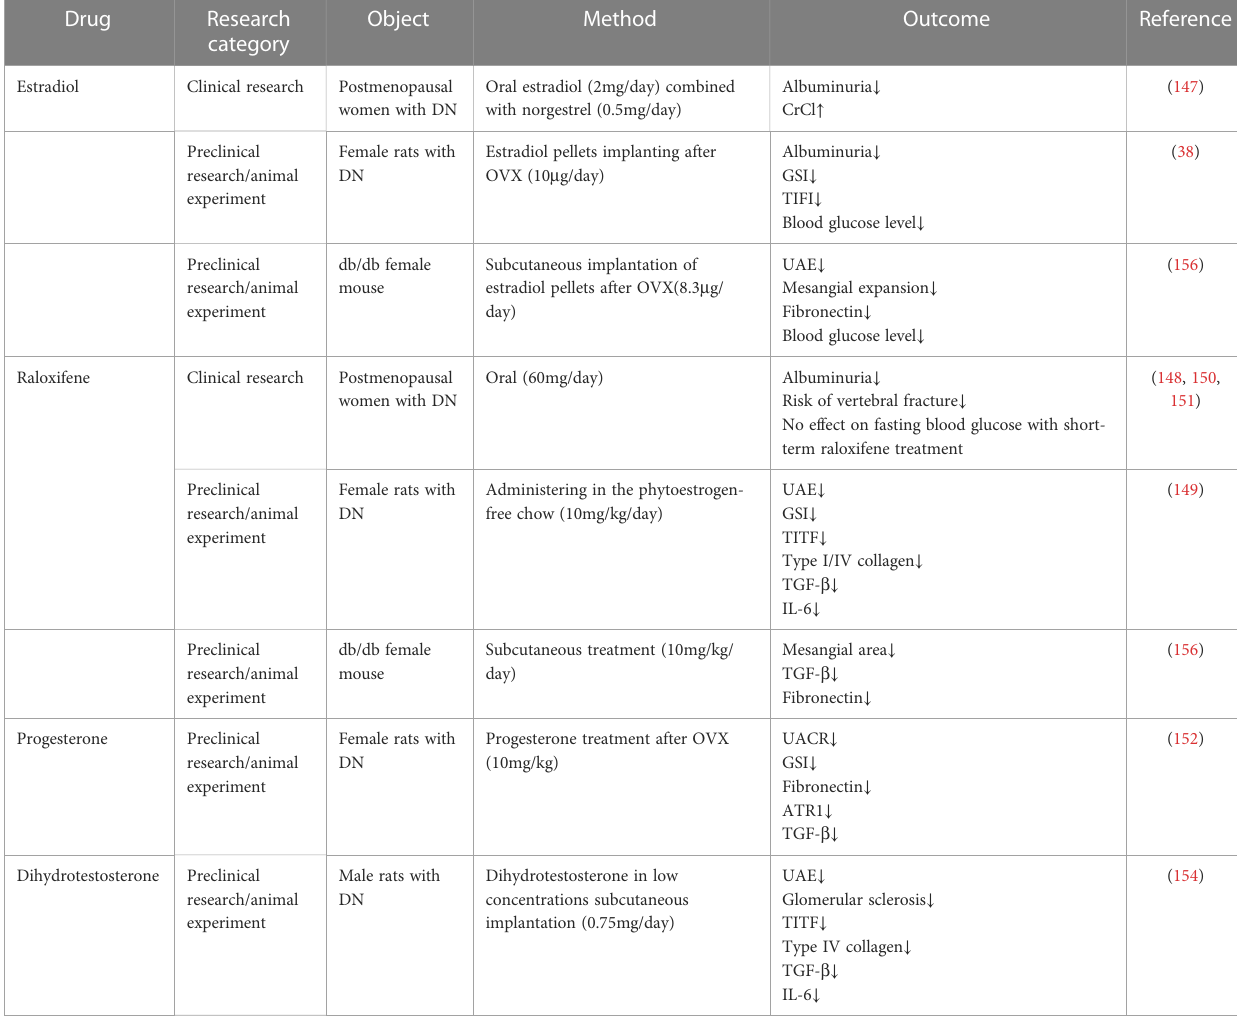
TABLE 2 Sex hormone replacement therapies in